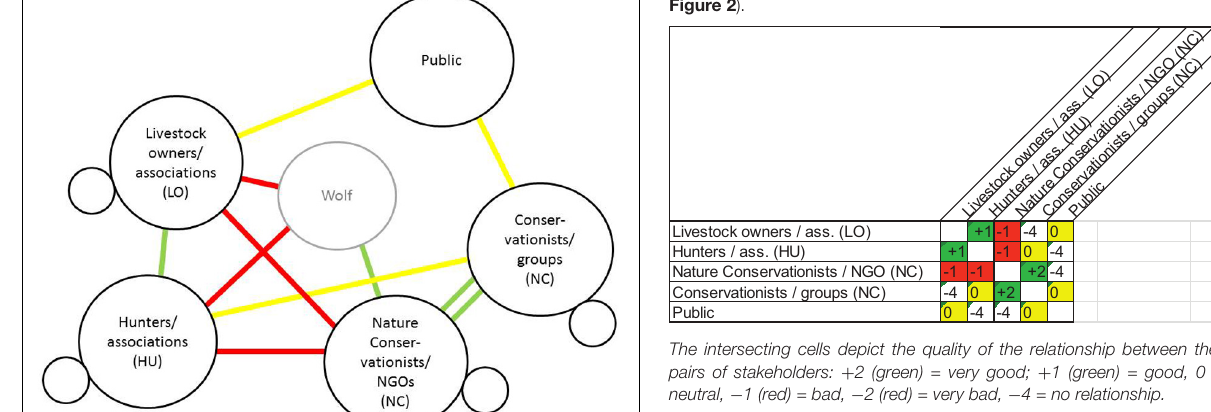
TABLE 3 | Scheme of the original actors-matrix with all stakeholders mapped around “Wolf” in Germany (DE).